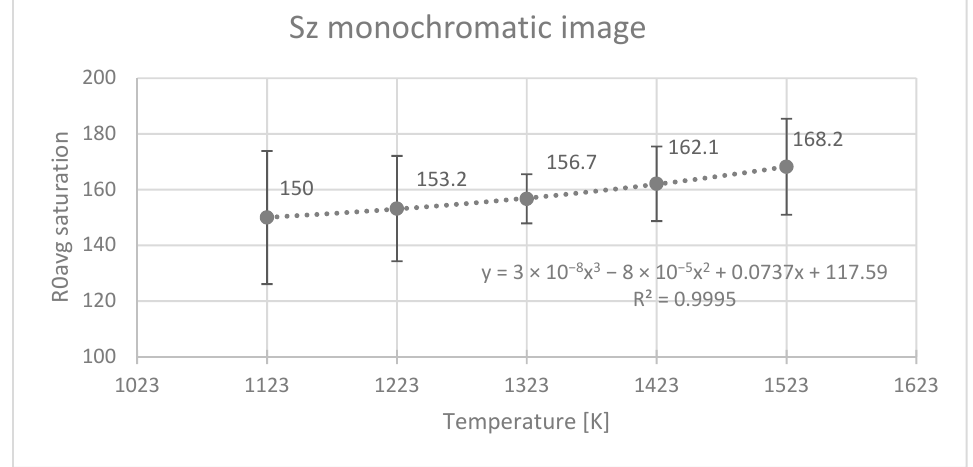
Figure 16. Mean R0 value of Sz greyscale levels. (Reprinted with permission from Ref. [8]. 2022, AFIT.)